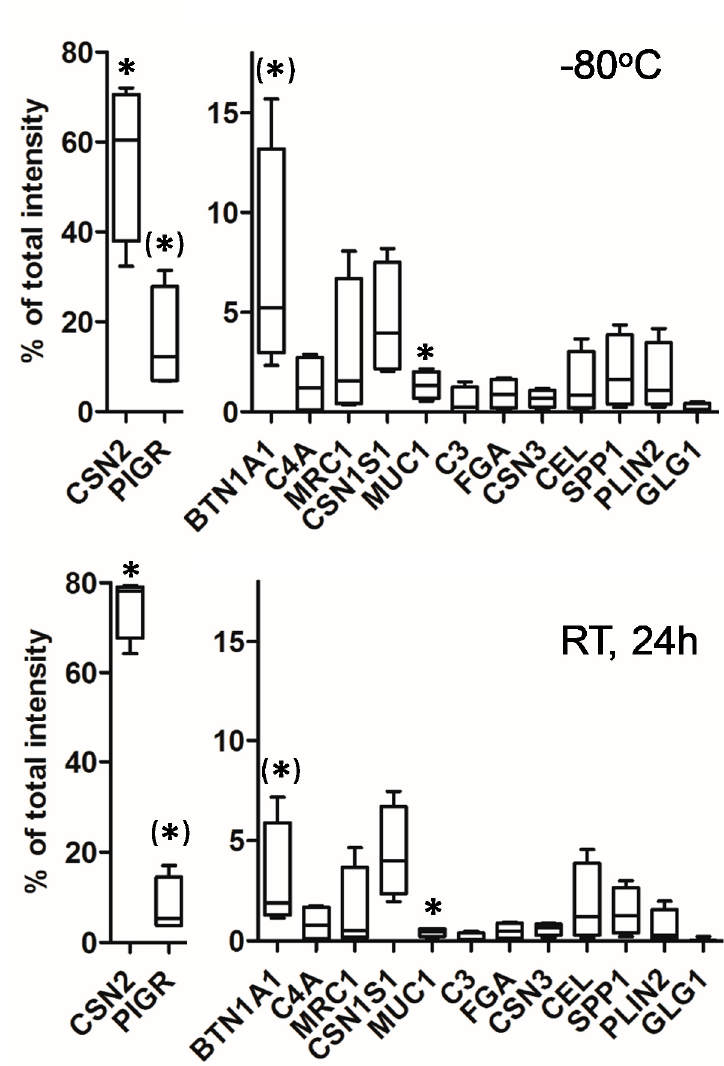
Figure 3. Percentage of the total intensity of 14 proteins representing the 10 most abundant proteins per sample. Boxes display the variation across the milk samples of four different mothers immediately frozen at − 80 °C or stored for 24 h at RT. Difference in abundance after storage in the two different conditions was calculated by paired t -test. Lines indicate median values. Whiskers are set to minimum and maximum values. * p < 0.05; (*) PIGR p = 0.06; BTN1A1 p = 0.08. CSN2, beta-casein; PIGR,